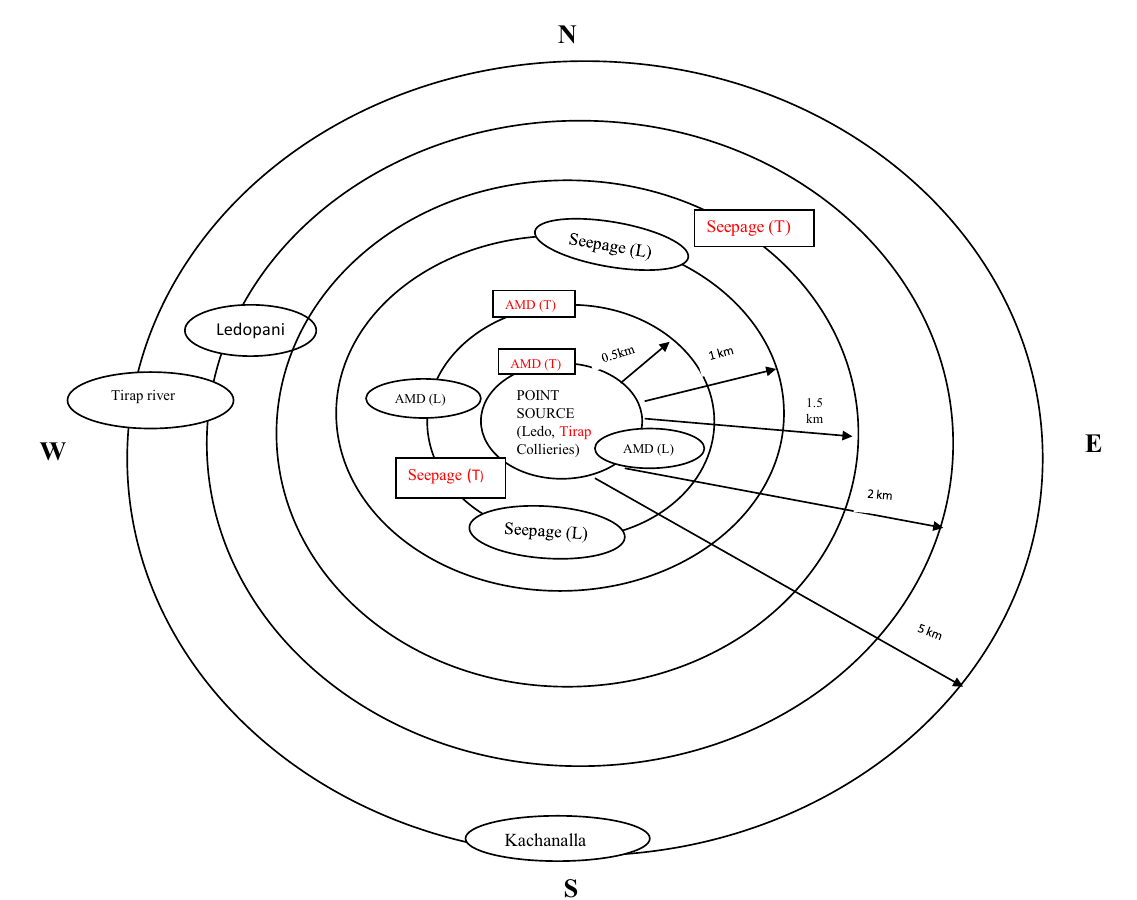
Fig. 2 Schematic diagram showing the actual sampling locations in around Ledo colliery (Open cast